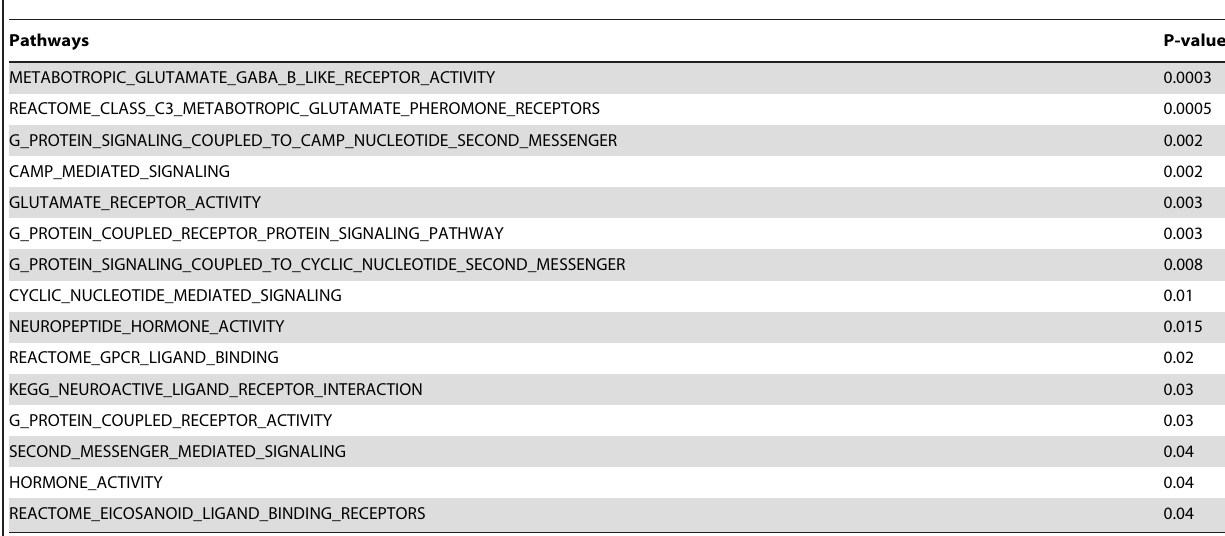
Table 3. Top 15 enriched pathways in module #